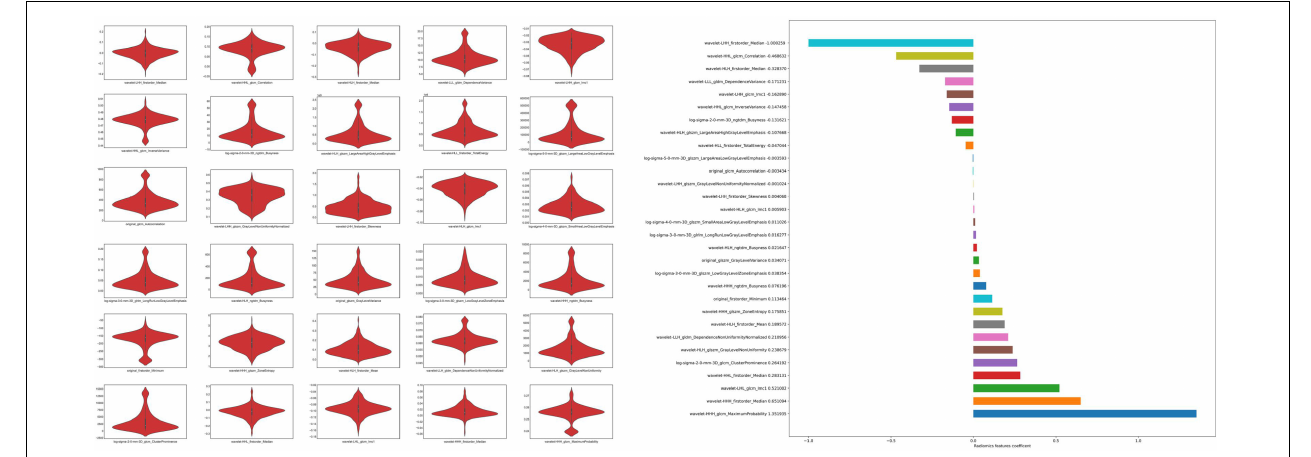
FIGURE 6 | Significant radiomic features and feature